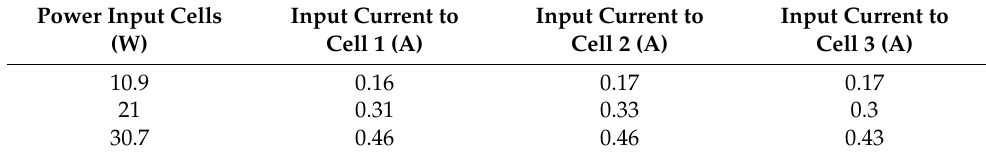
Table 1. Load sharing between three buck